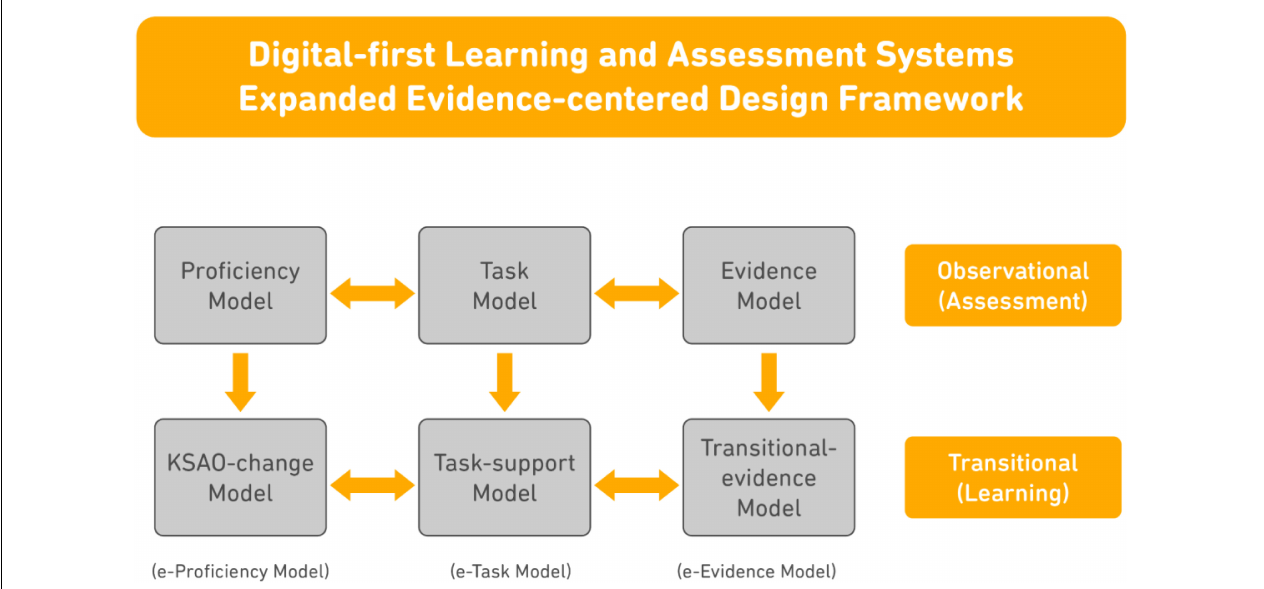
FIGURE 2 | The Expanded Evidence-centered Design framework emphasizes transitional learning with